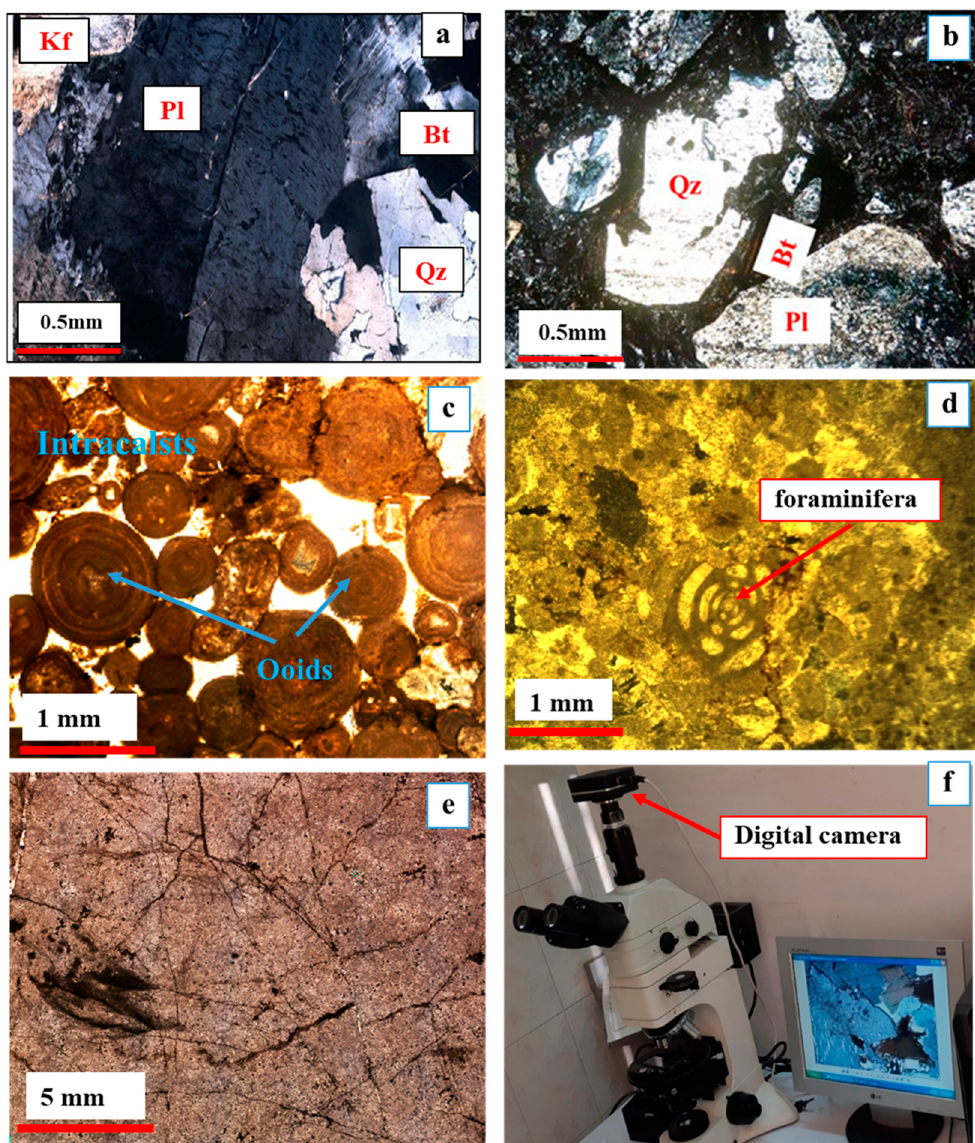
Figure 4. Microstructure of aggregates: ( a ) granite; ( b ) rhyodacite; ( c ) Bathurst limestone; ( d ) Ilam limestone; ( e ) dolomite; ( f ) optical microscope equipped with a digital camera and polarized light. Table 1. X-ray diffraction results of different aggregates.